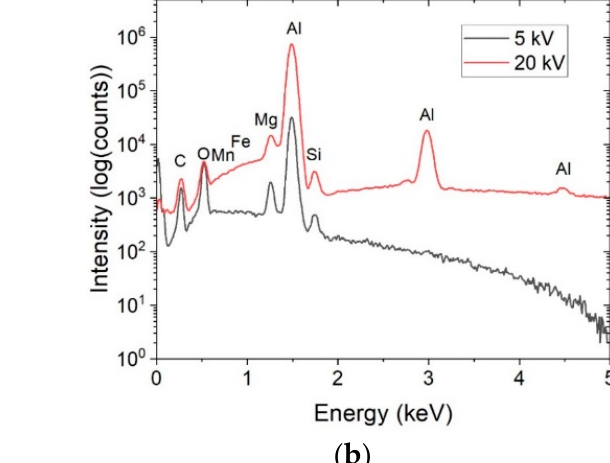
Table 1. Comparison between theoretical composition of Al6082, and the measured composition with EDS at 5 kV and 20